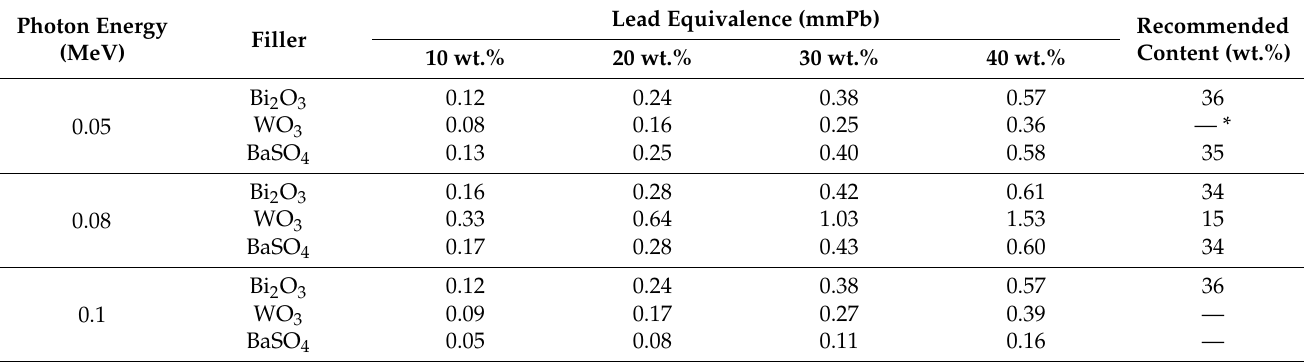
Table 7. Pb eq values of Bi 2 O 3 /PVA, WO 3 /PVA, and BaSO 4 /PVA hydrogels containing varying filler contents of 10, 20, 30, and 40 wt.%, determined at photon energies of 0.05, 0.08, and 0.1 MeV using